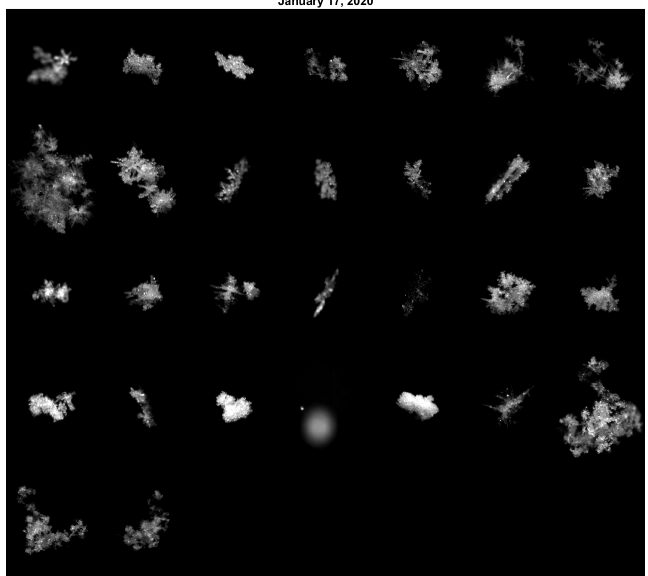
Figure C2. MASC snowflake imagery for 17 January